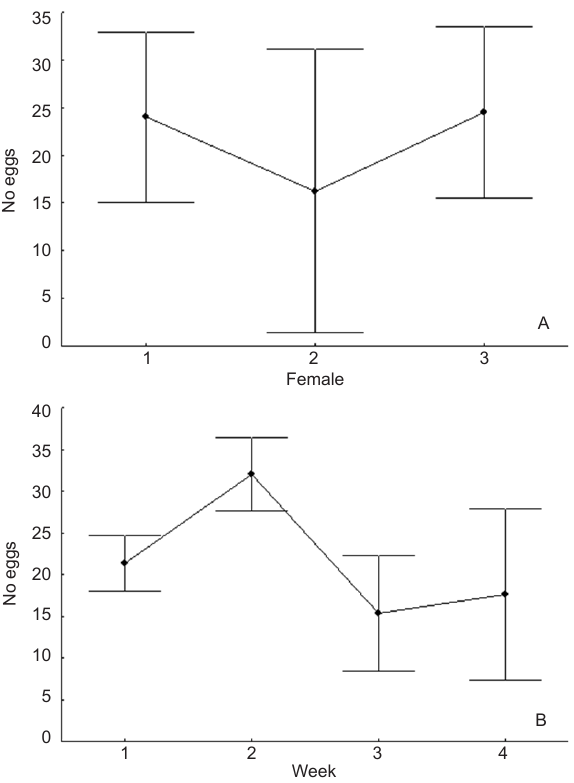
Figure 1. Fecundity mean (±SD) of each female of Austrolebias nigrofasciatus confined for four weeks in natural environment (A) and mean of weekly fecundity